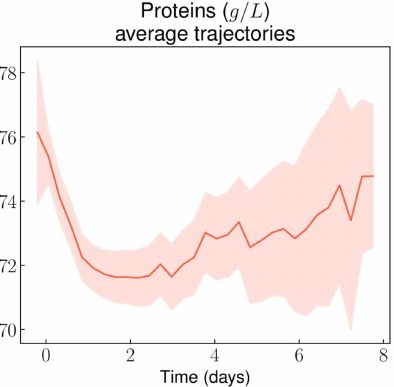
Figure A9. Protein average trajectory throughout non-complicated VOC-related hospital stays.